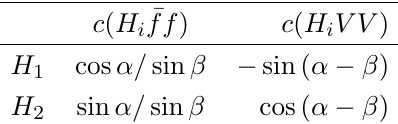
Table 3 . Yukawa and gauge boson coupling modi(cid:12)ers for the CP-even Higgs bosons H i ( i = 1 ; 2) in the